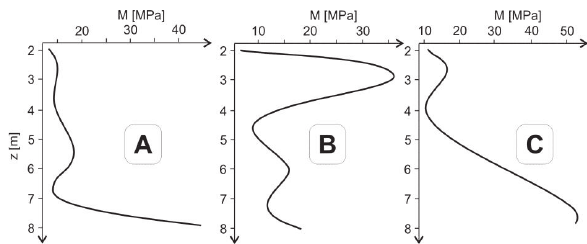
Figure 11. Graphs of mean of the function f(z)=M for isolations A, B and C assumed in the depth range of 2 - 8 m.